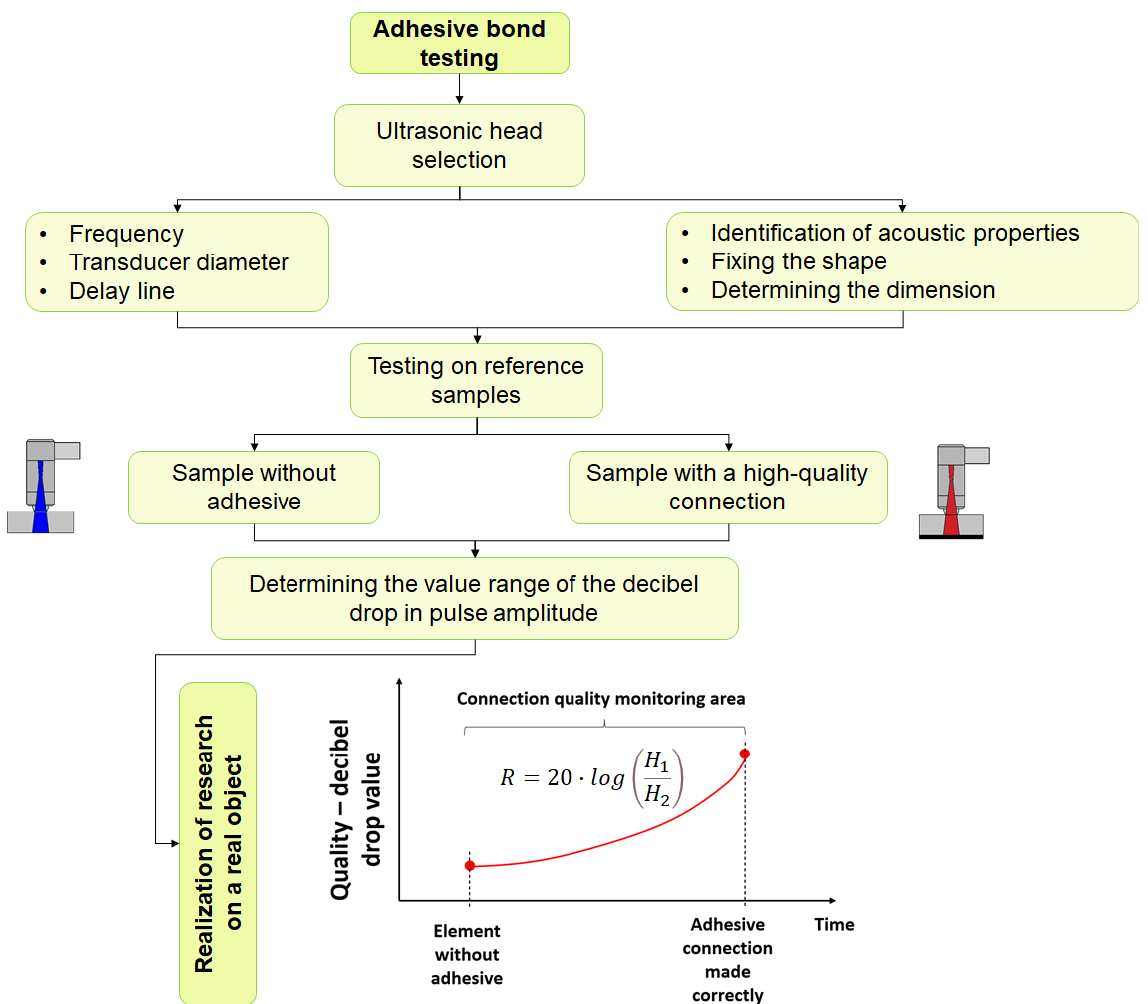
Figure 9. A procedure during monitoring the condition of the adhesive bond by ultrasonic